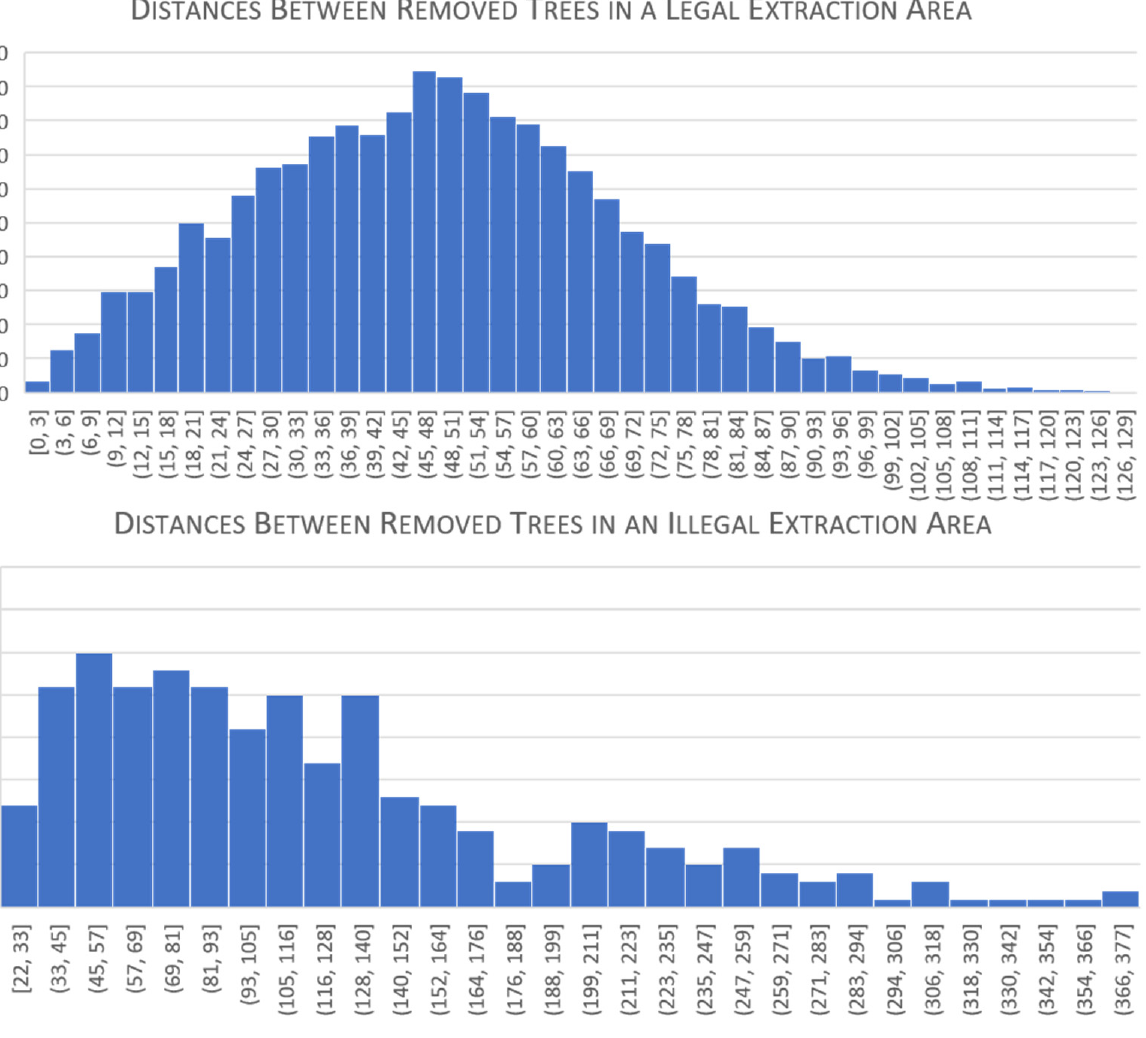
Figure 7. Distribution of distances between clearings in legal and illegal selective logging.